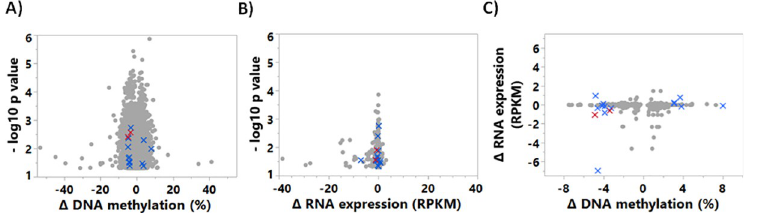
Fig 3. Distribution of p-values within RIDMs and RIREs of asthmatics vs controls. Changes were identified for individual CpG DNA methylation (A) and mRNA expression (B) between children with and without asthma, using ANOVA. Representation of the HRVI-induced associated changes ( Δ = HRVI-MOCK) of CpG DNA methylation and mRNA expression change are shown in (C). The crosses display the16 targets with a HRVI-induced change in DNA methylation (minimum-change 3%) and mRNA expression (minimum-change 0.1 RPKM). Red crosses represent the changes in BAT3 and NEU1 .